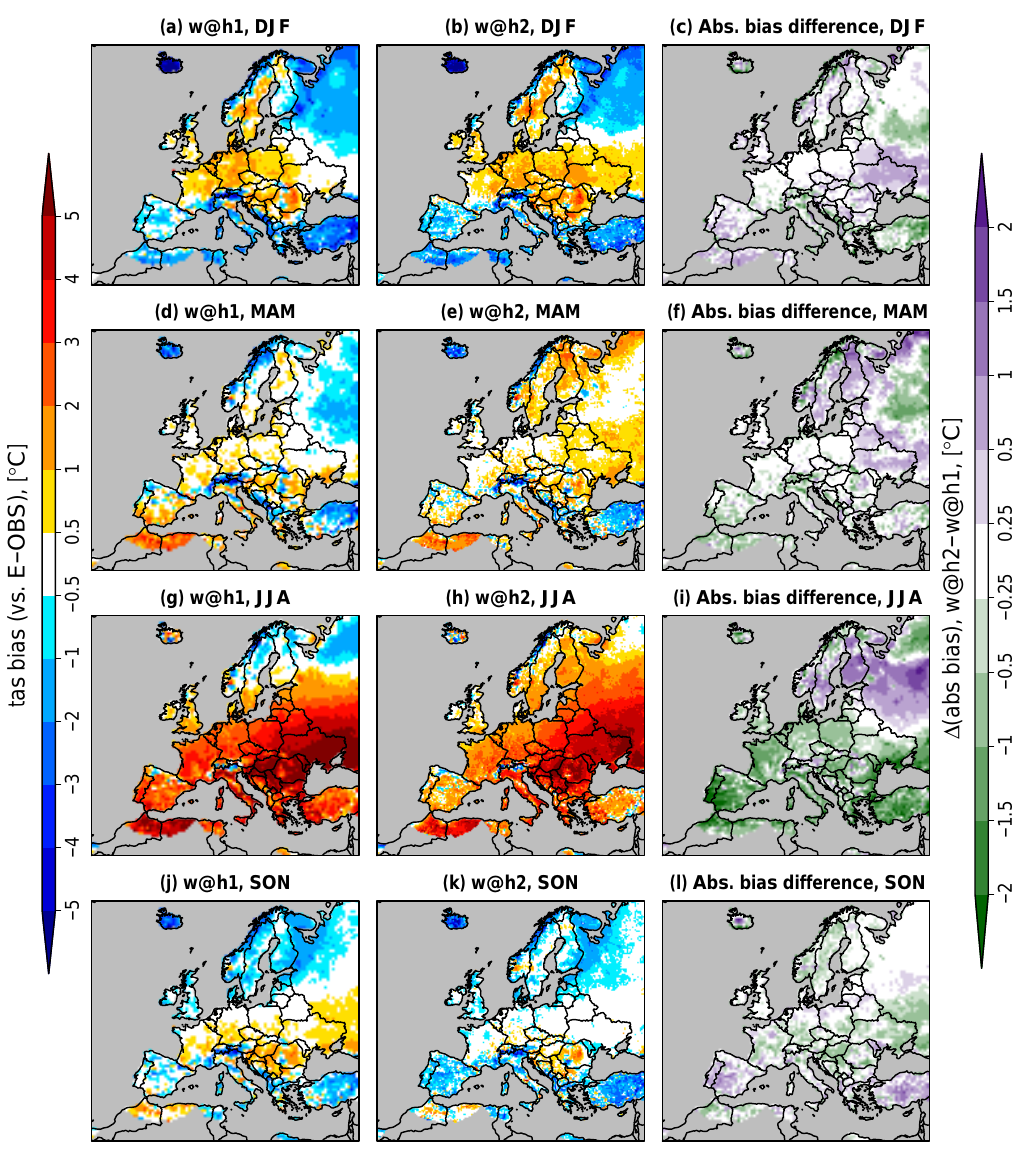
Figure 6. Biases in surface air temperature for the HadRM3P RCM in w@h1 (left; a, d, g, j ) and w@h2 (middle; b, e, h, k ), and the difference in absolute biases (right; c, f, i, l , expressed as w@h2 minus w@h1, i.e. negative values indicate an improvement). Each row corresponds to a season (from top to bottom: DJF, MAM, JJA, SON). The biases are computed at the respective model resolution, while the absolute bias difference is computed on the 0 . 44 ◦ grid. Biases are computed with respect to the E-OBS dataset and are expressed in ◦